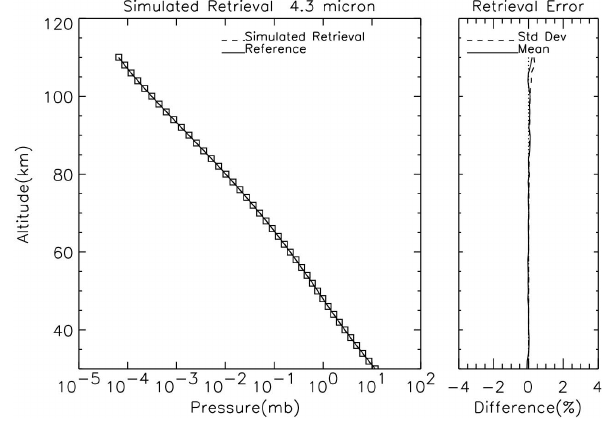
Fig. 12. Same as Fig. 11 but for pressure.